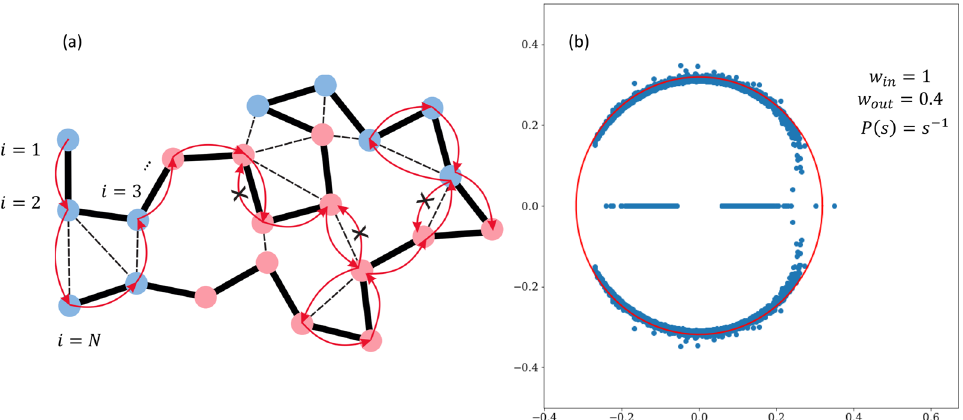
Figure 2. ( a ) Depiction of the polymer SBM network: the backbone (bold), contacts between genomically distant monomers (dashed) and two chemical sorts of the monomers (red and blue), arranged into contiguous alternating segments. An example of the non-backtracking walk on such graph is shown by arrows. Immediate returns are forbidden, preventing localization on hubs; ( b ) Spectrum of the polymer non-backtracking flow (11) 1 ) large-scale organization of the chain with two overlaid compartments with s for the fractal globular ( P ( s ) − = 100 the mean length (cid:31) =